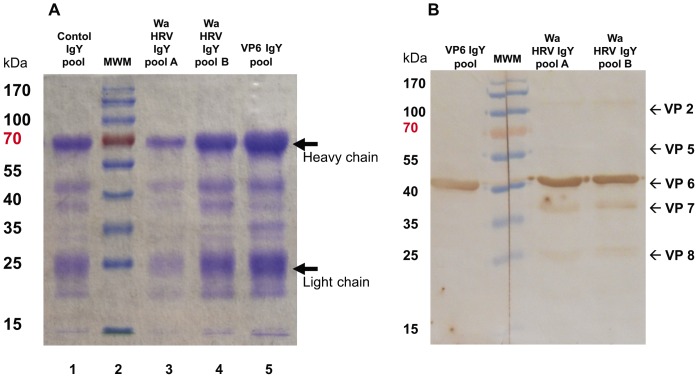

In vitro characterization of VP6 specific and Wa HRV specific chicken egg yolk IgY Abs and control IgY Abs used for this experiment.
A- Coomasie blue stained SDS-PAGE of IgY Abs in control IgY (line 1), Wa HRV pool A (line 3) and pool B (line 4) and VP6 IgY pool (line 5). Total protein loaded in each lane: Lane 1 = 19.2 µg; Lane 3 = 18.8 µg; Lane 4 = 28.1 µg; Lane 5 = 31.2 µg. Lane 2: molecular weight marker (MWM; Fermentas, Thermo Fisher Scientific Inc., USA). Arrows indicate the light and heavy chain of IgY Abs. B- Immunoblot analysis of Wa HRV SDS-PAGE incubated with VP6 IgY pool or Wa HRV IgY pool A and B. Approximately 5 µg of purified Wa HRV were loaded in the SDS-PAGE. The SDS-polyacrylamide gel was transferred to a nitrocellulose membrane and then one segment was incubated with Wa HRV specific IgY Abs from pool A (1∶200 dilution from the stock), another segment was incubated with Wa HRV specific IgY Abs from pool B (1∶1000 dilution from the stock) and the third segment was incubated with VP6 IgY pool (1∶1000 dilution from the stock). After washing, the segments of membrane were incubated with peroxidase label goat anti chicken IgY polyclonal serum (Jackson ImmunoResearch Laboratories Inc.; USA). The Western blot assay was developed with 3,3′-diaminobenzidine (DAB).